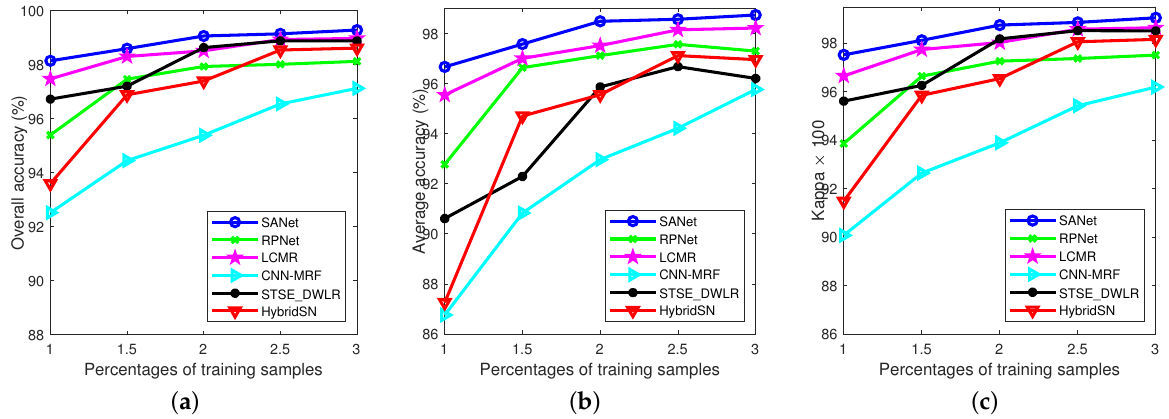
Figure 13. Experimental results of different methods with various numbers of training samples on Pavia University data set. ( a ) OAs; ( b ) AAs; ( c ) κ coefficients.